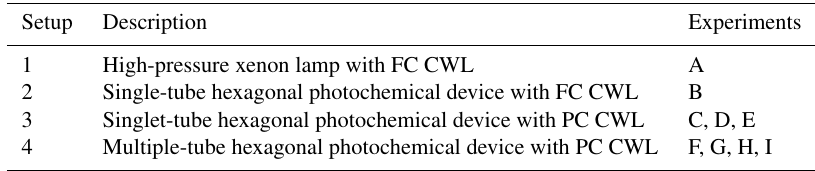
Table 1. Table summarizing experiments and setups. See Fig. B1 for an overview. FC: flow-controlled. CWL: chlorine waste line. PC: pressure-controlled.